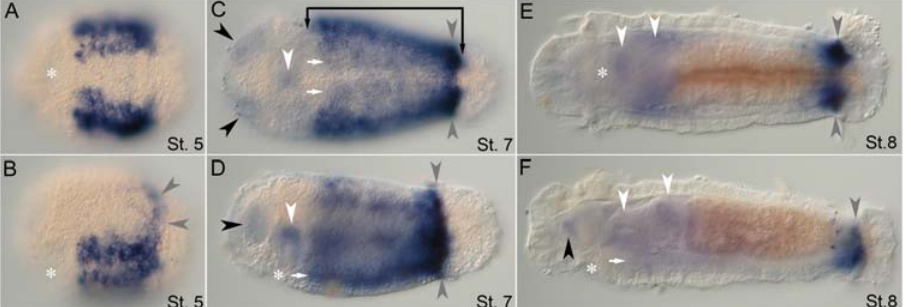
Figure 5. Larval expression of CapI-Hox3 . Anterior is to the left for all panels. Stages indicated at bottom right of each panel. (A), (C), and (E) show ventral views; (B), (D), and (F), lateral views with ventral down. Position of the mouth is marked by an asterisk. (A, B) CapI-Hox3 is expressed in the ventrolateral ectoderm of all segments and in the growth zone (stage 5) (gray arrowheads). (C, D) Expression in the lateral epidermis (bracket) and VNC (VNC, white arrows) of all segments, and in the posterior growth zone (gray arrowheads) at stage 7. Black arrowhead marks brain expression. White arrowhead marks expression in the dorsal wall of the stomodeum. (E, F) At late stage 8/early stage 9, expression is prominent in the posterior segments and growth zone (gray arrowheads), and weak in the VNC (white arrow), esophagus and pharynx (white arrowheads), and brain (black arrowhead).